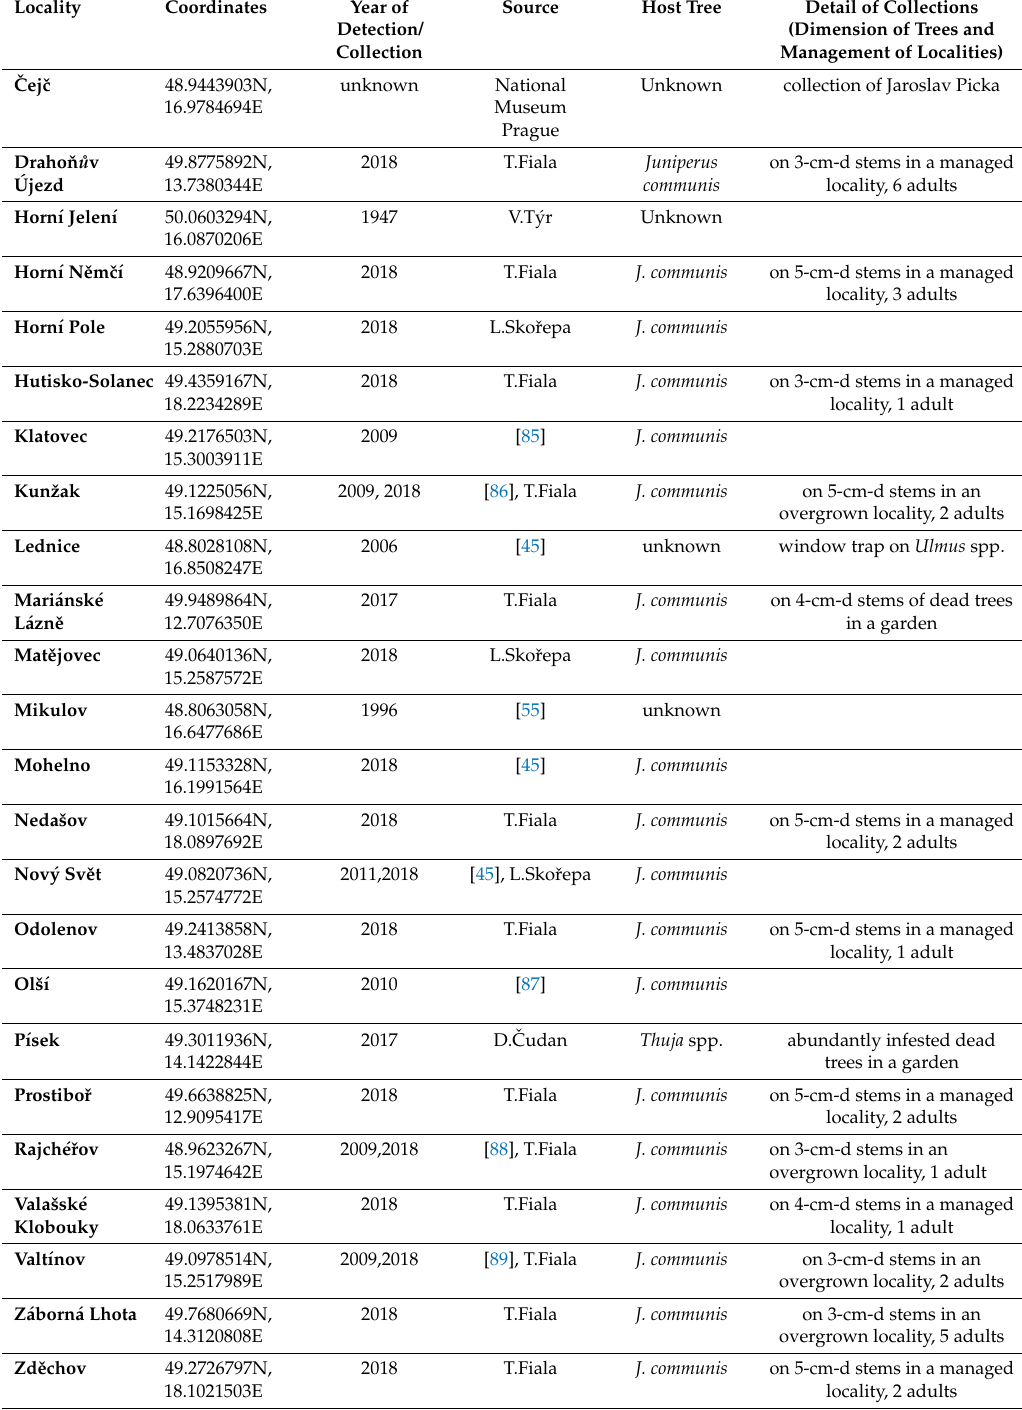
Table A1. Details of localities in the Czech Republic where P. aubei was detected in the current study (2018) and in earlier